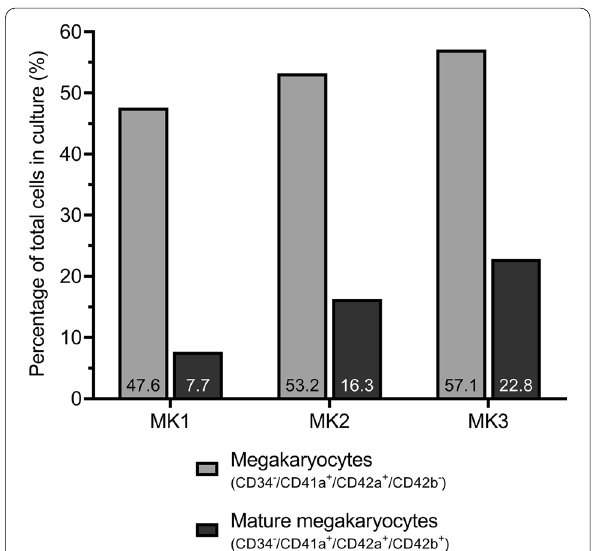
Fig.2 The differentiation status of megakaryocytes in three cell culture batches (MK1-3) assessed by flow cytometry. Of the three megakaryocytic cell culture batches from three different healthy adult HSPC donors (MK1-3), MK3 has both the most megakaryocytes and the most mature megakaryocytes after 9 days of differentiation. The results were based on flow cytometry expression of